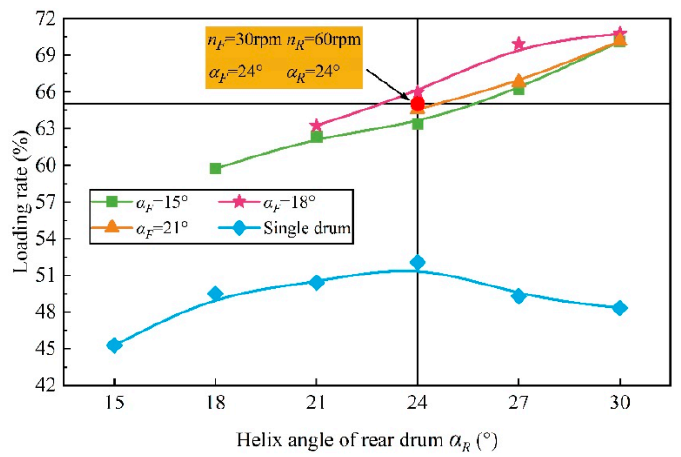
Figure 19. The loading rate of the different matching relationship of helix angle between front and rear